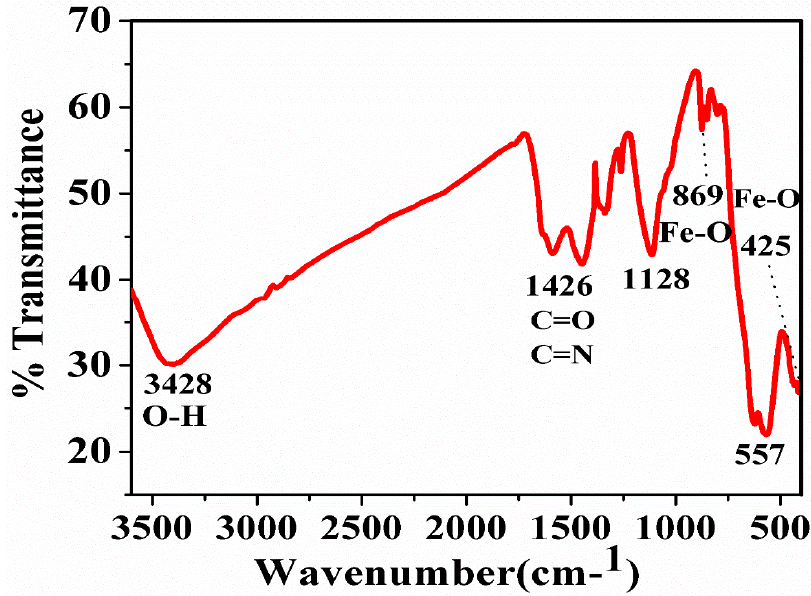
Figure 2. Fourier transform infrared (FTIR) spectra of IONPs synthesized by sonochemical method.